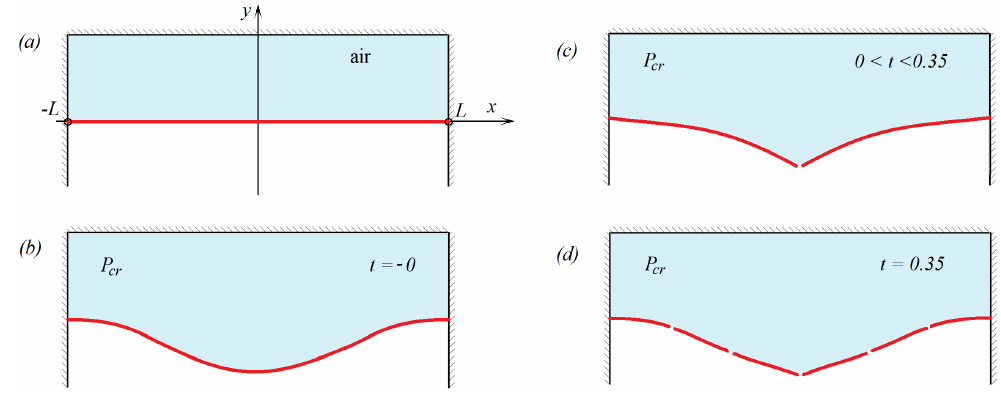
Figure 1. Sketch of the clamped plate broken by the air pressure; ( a ) Initial horizontal position of the plate with the air pressure inside the chamber being equal to the external ambient pressure, ( b ) shape of the plate before its first breaking, ( c ) dynamical shape of the plate after the first breaking but before the second one, ( d ) the second breaking of the plate without increase of the the